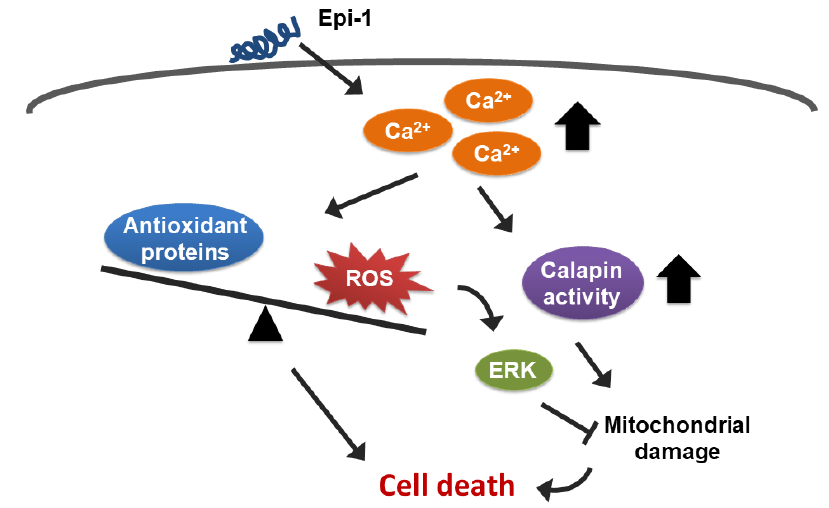
Figure 8. A summary diagram showing how epi-1 induces cell death in synovial sarcoma cells. Epi-1 increases intracellular levels of calcium. Elevated calcium induces oxidative stress and calpain activity. Activated calpain causes mitochondrial damage. Both mitochondrial damage and oxidative stress contribute to cell death. ROS also activates ERK, which plays a protective role in epi-mediated cytotoxicity. Thin arrowheads: induction; Thick arrowheads: elevation; T bar: inhibition.